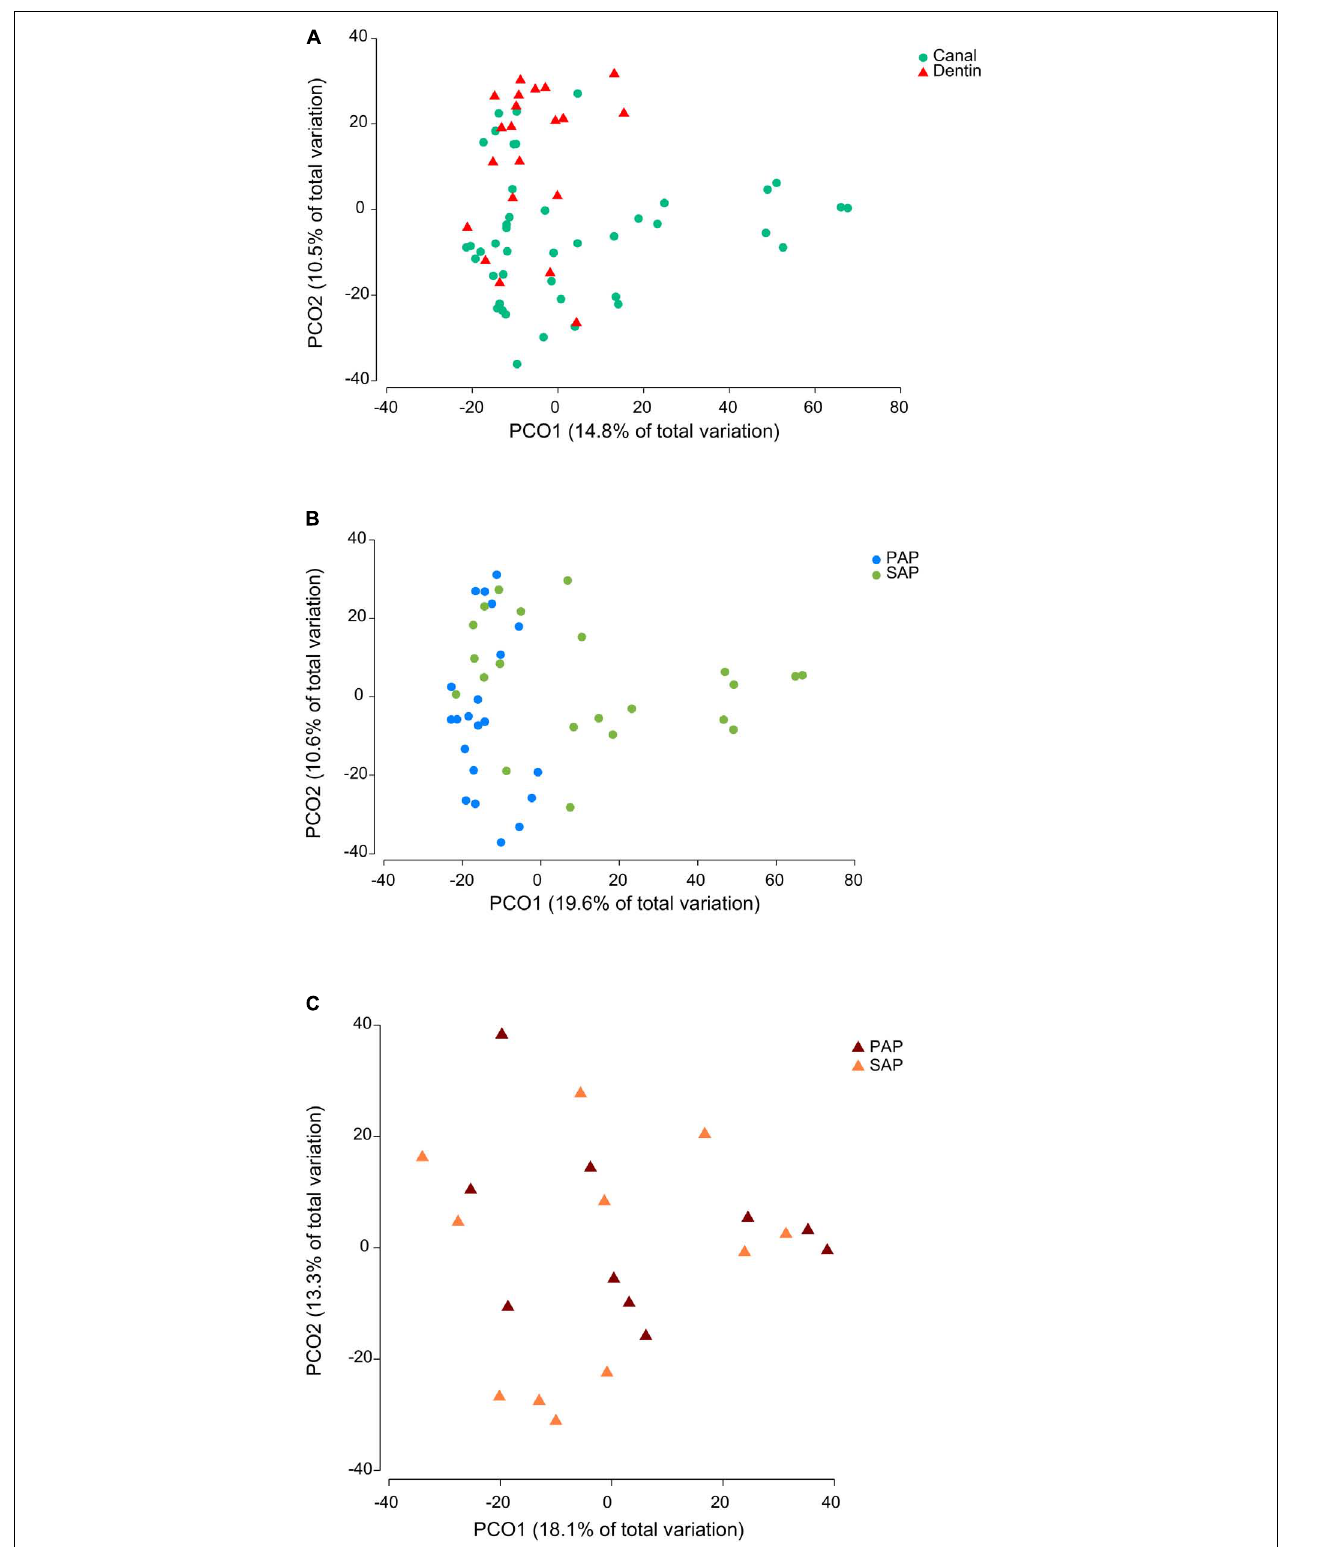
FIGURE 2 | Principal coordinate analysis of Bray–Curtis similarity of bacterial communities. The analysis was based on square root-transformed proportions of OTUs and included either all (A) , root canal (B) , or dentin samples (C) . PAP, primary apical periodontitis; SAP, secondary apical periodontitis.